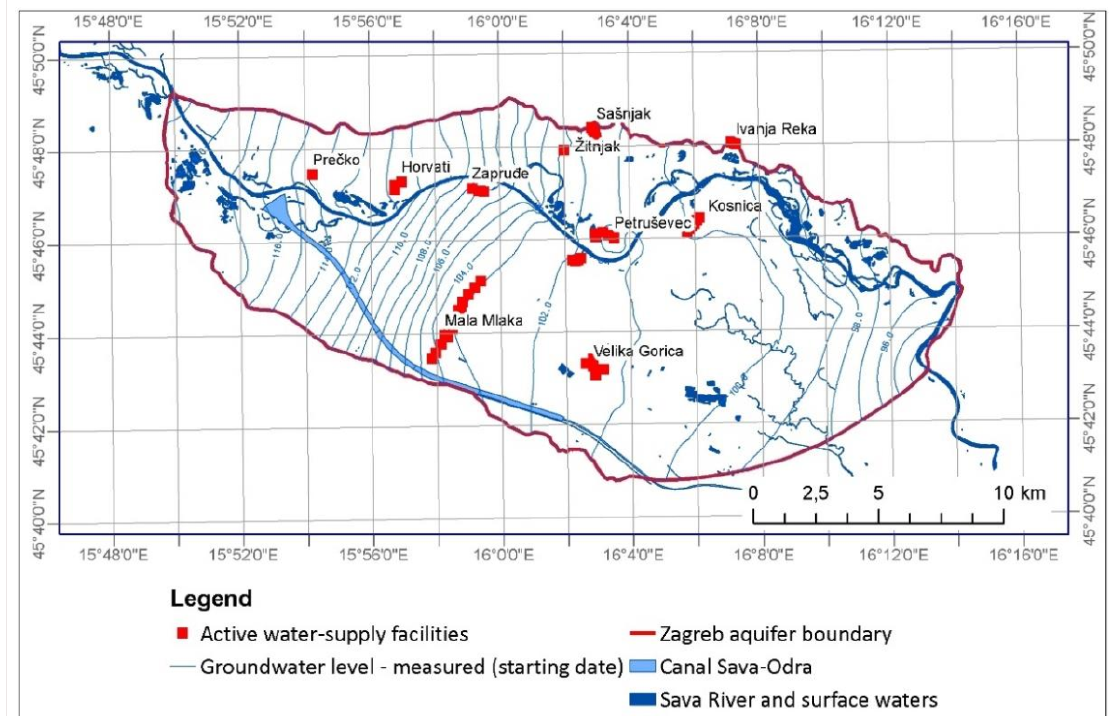
Figure 6. Initial distribution of groundwater levels for the starting date of the